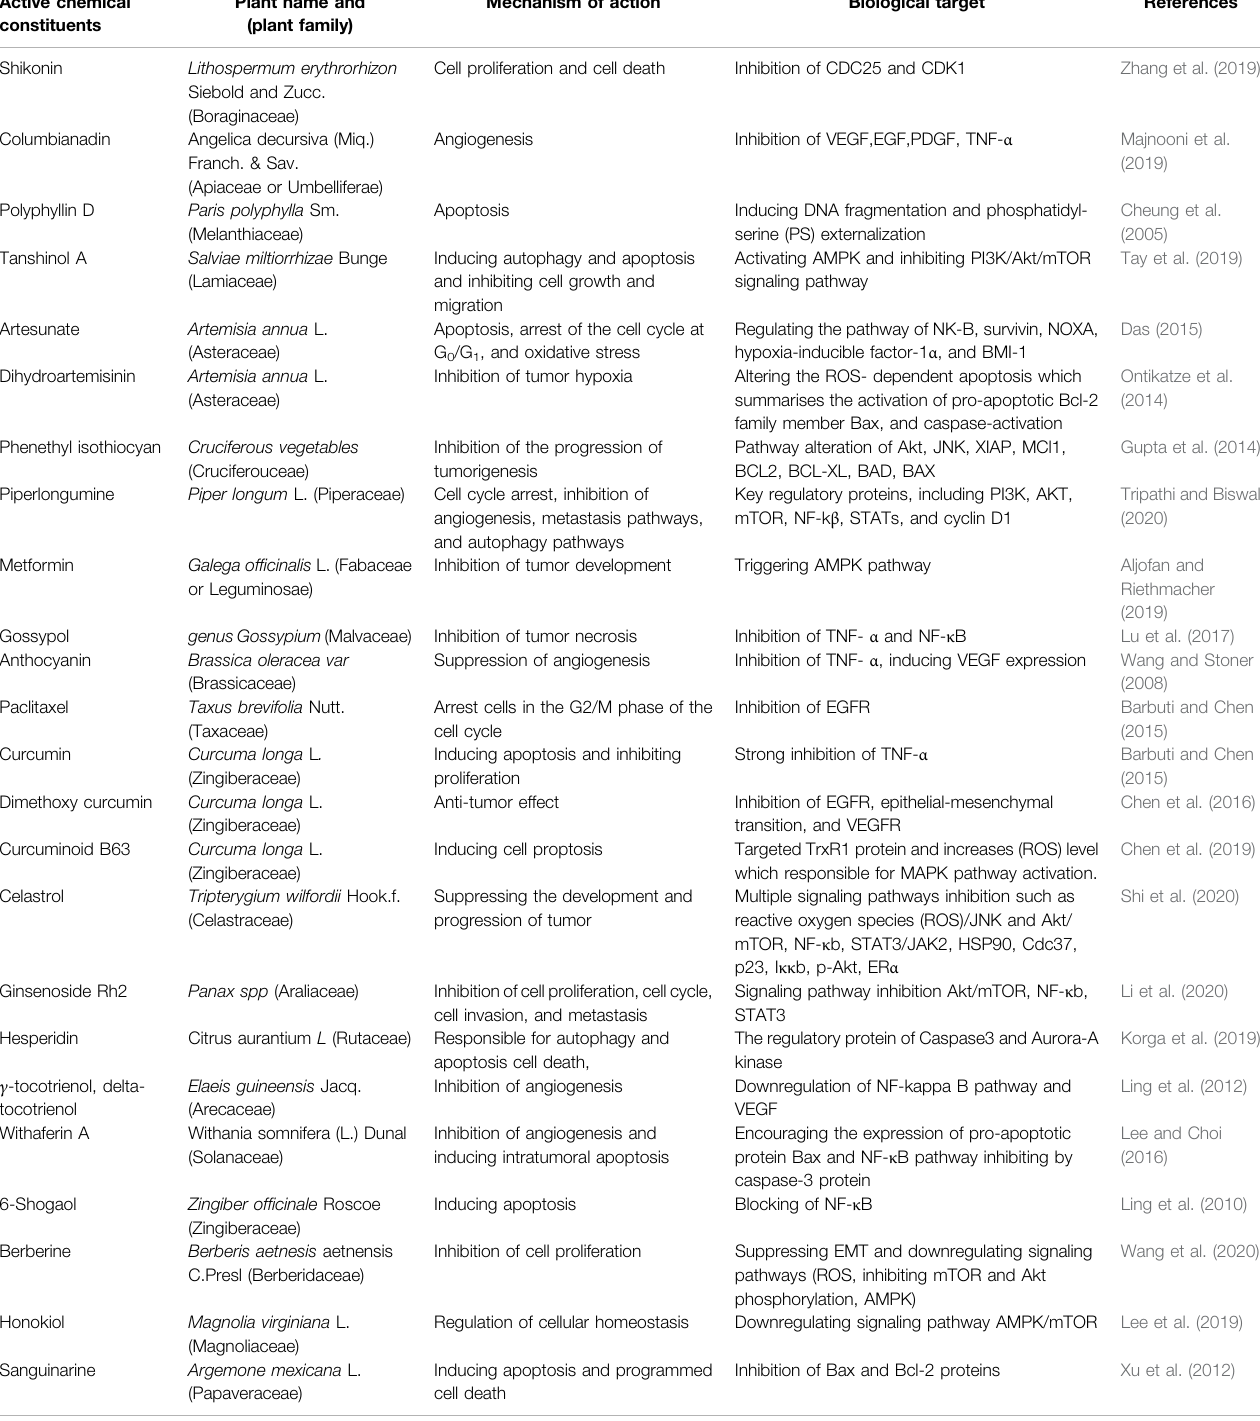
TABLE 1 | Pharmacological and Pharmacognostic details of the naturally occurring anticancer